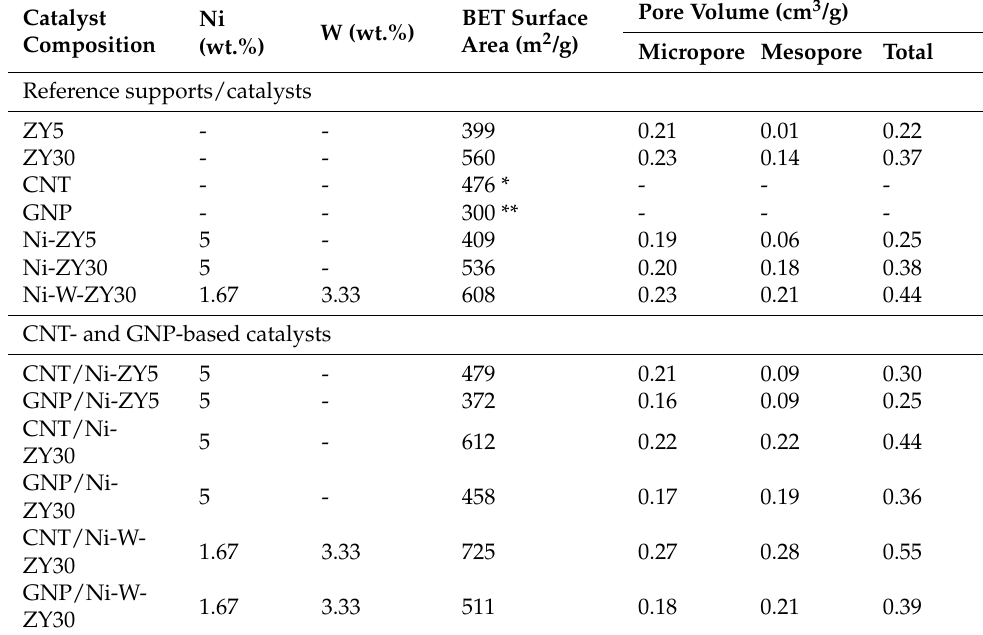
Table 1. Textural properties of the prepared